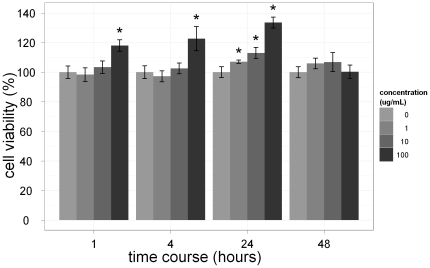
Macrophages were incubated in the absence (control) or presence of 1, 10, and 100 µg/ml of SPIO particles for 1, 4, 24, and 48 h.The effect of SPIO particles on cell viability was determined via MTT assays immediately after incubation. Data are expressed as the mean and error of three determinations, with each assay performed in triplicate. Dunnett's test treats one group as a control and compares all other groups against it. *p<0.05.